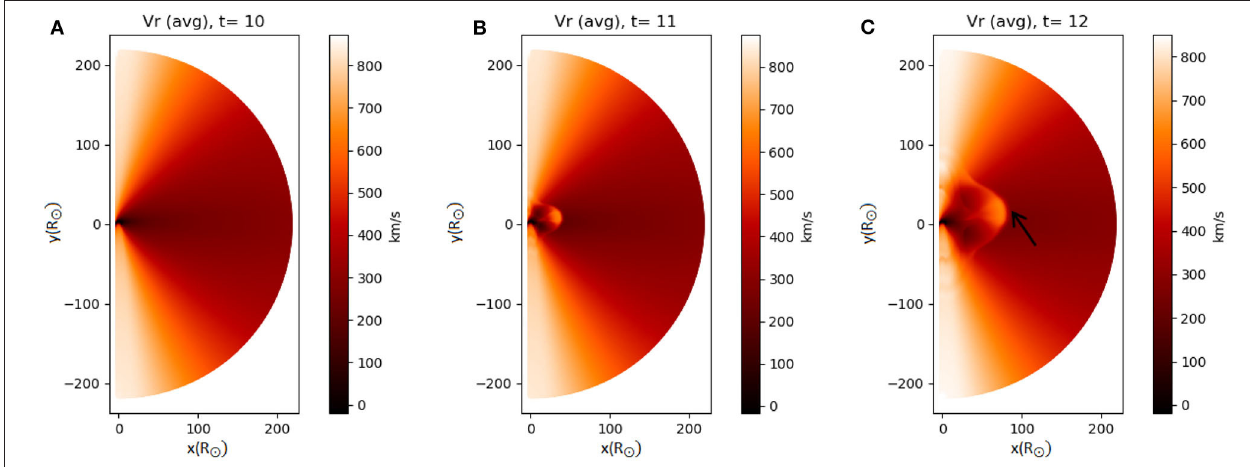
FIGURE 10 | Injection and propagation of a CME via the average radial velocity in the ensemble (in km/s). From (A–C) : relaxed solar wind ( t = 10), injection and propagation of the CME ( t = 11, t = 12). The leading edge (front shock) is prominent in the last panel, marked by a black